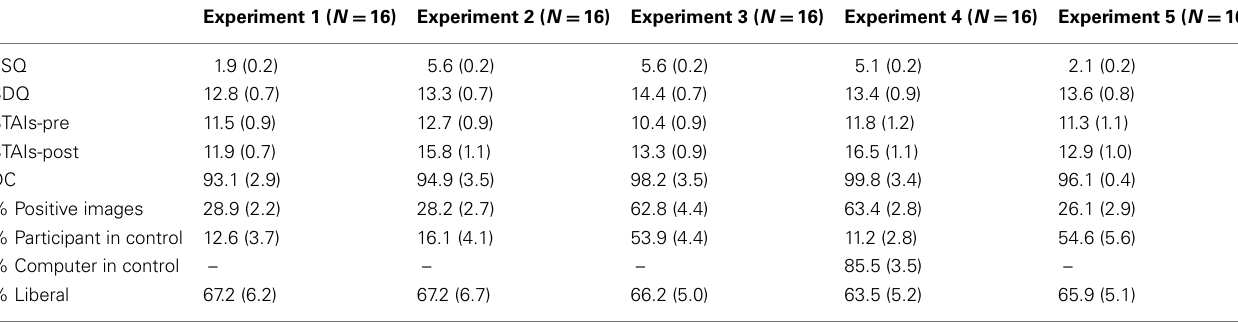
Table 1 | Mean scores (standard errors in parentheses) from the experimental questions and questionnaires completed in Experiments 1–5.